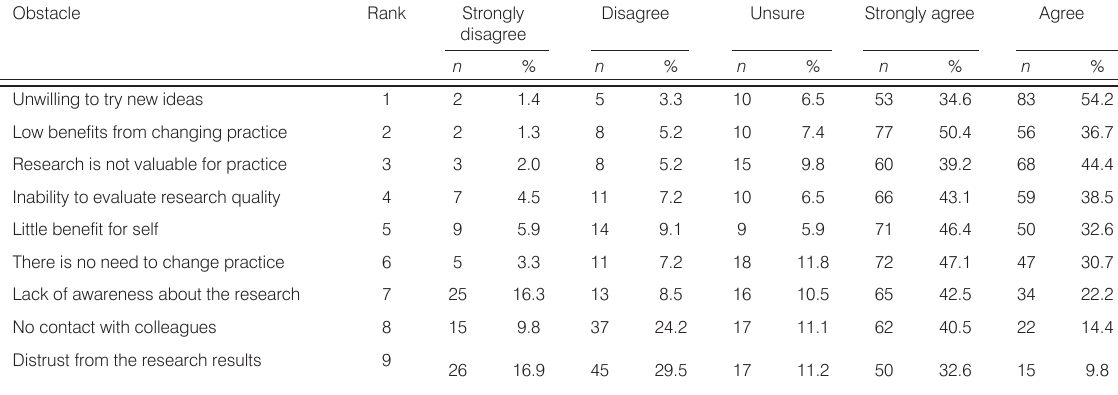
Table 2. Distribution of study sample regarding individual characteristics (N = 154).